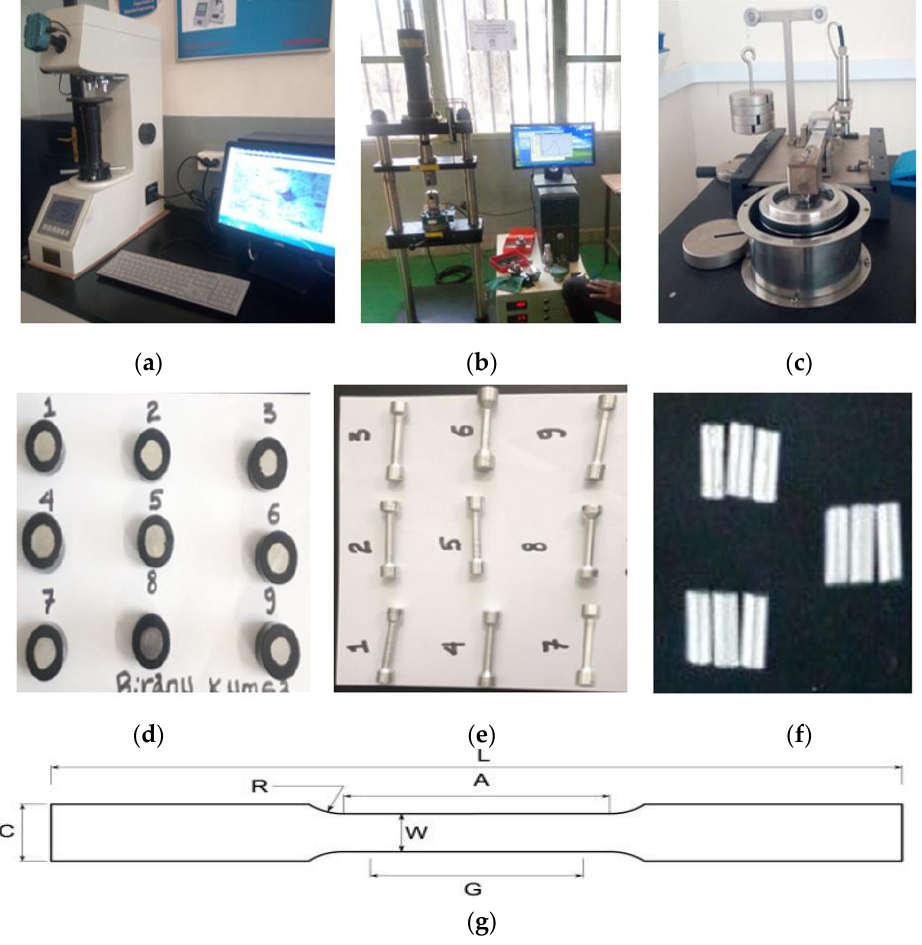
Figure 1. Testing devices and specimens. ( a ) Hardness testing; ( b ) Tensile testing; ( c ) Wear testing; ( d ) Hardness test sample; ( e ) Tensile test sample; ( f ) Wear test sample; ( g ) Sample size for tensile testing.